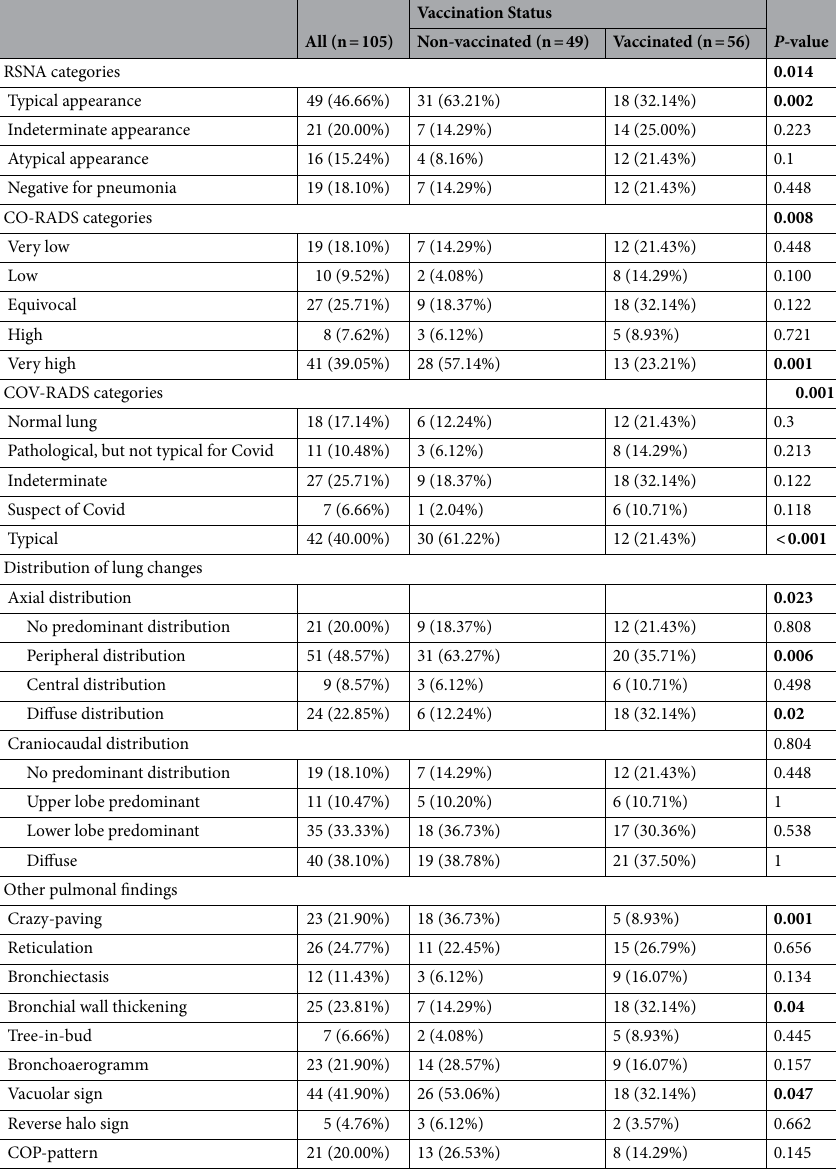
Table 2. Qualitative scoring-CT-graphic pulmonary manifestation of COVID-19-infection according to vaccination status. For categorical variables, values are counts and percentages with P ‐ values from Fisher’s Exact Test. COP cryptogenic organizing pneumonia. Significant P -value < 0.05. Significant values are in